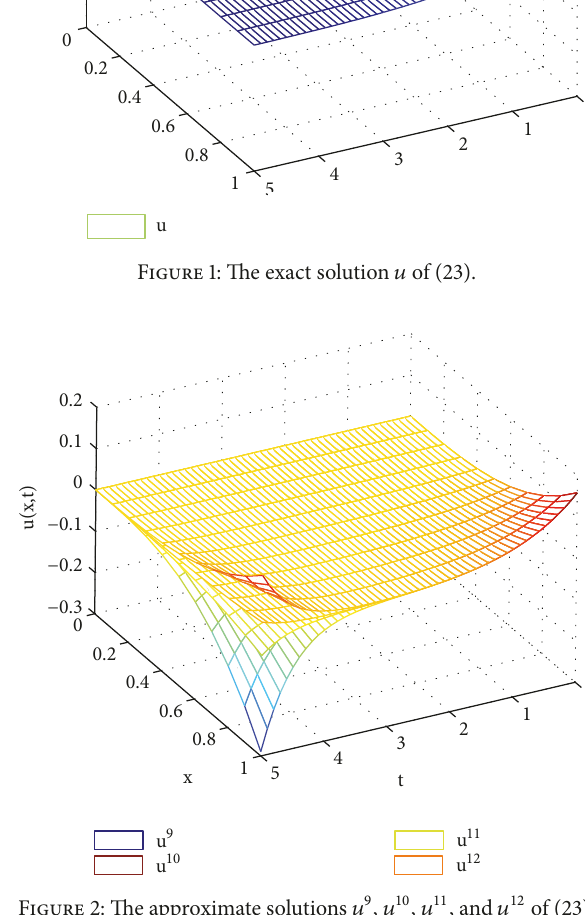
Figure 2: The approximate solutions 𝑢 9 , 𝑢 10 , 𝑢 11 , and 𝑢 12 of